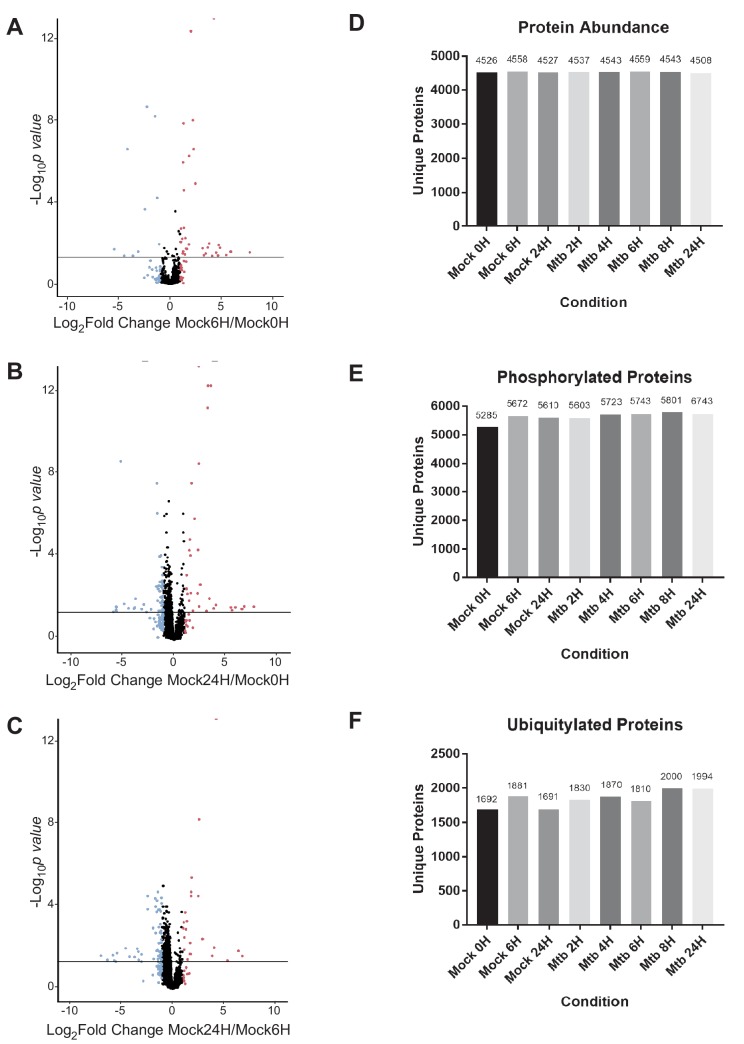
Host protein abundance changes in mock-infected macrophages, and unique host proteins identified at each time point 2–24 hr post-infection with Mtb or mock infection.(A–C) Volcano plots displaying the proteins changing in abundance during mock infection between 0- and 6 hr (A), 0- and 24 hr (B), and 6- and 24 hr (C). Proteins with a p value less than 0.05 and log2(fold change) greater than one are colored red. Proteins with a p value less than 0.05 and log2(fold change) less than −1 are colored blue. (D–F) Graph of the number of unique proteins identified by mass spectrometry in biological triplicate, technical duplicate samples for each experimental condition from unenriched (D), phosphoenriched (E), or di-Gly enriched (F) peptide samples.